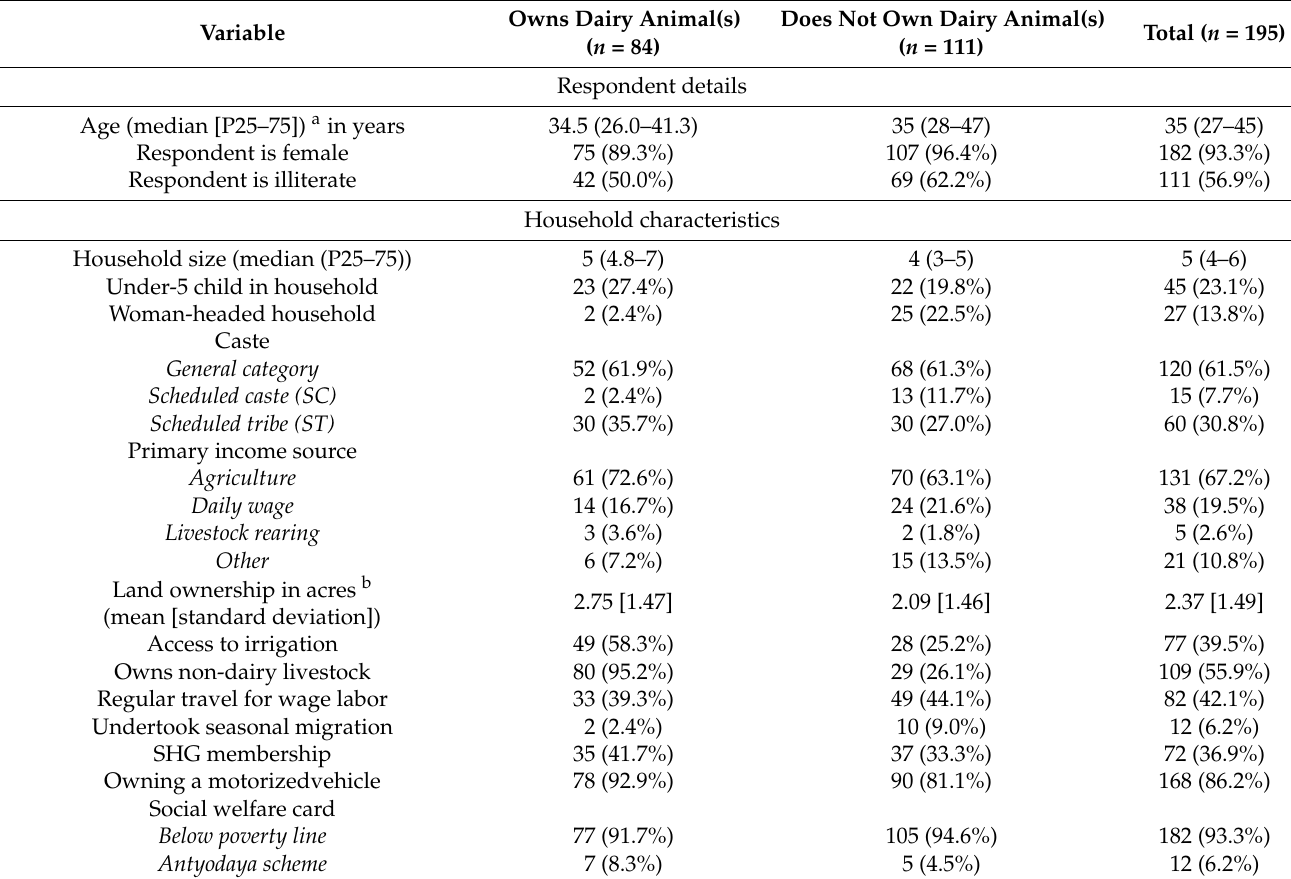
Table 1. Socio-demographic characteristics of the study population from a household survey conducted between April and July 2019 in four villages in Kolar district, India.